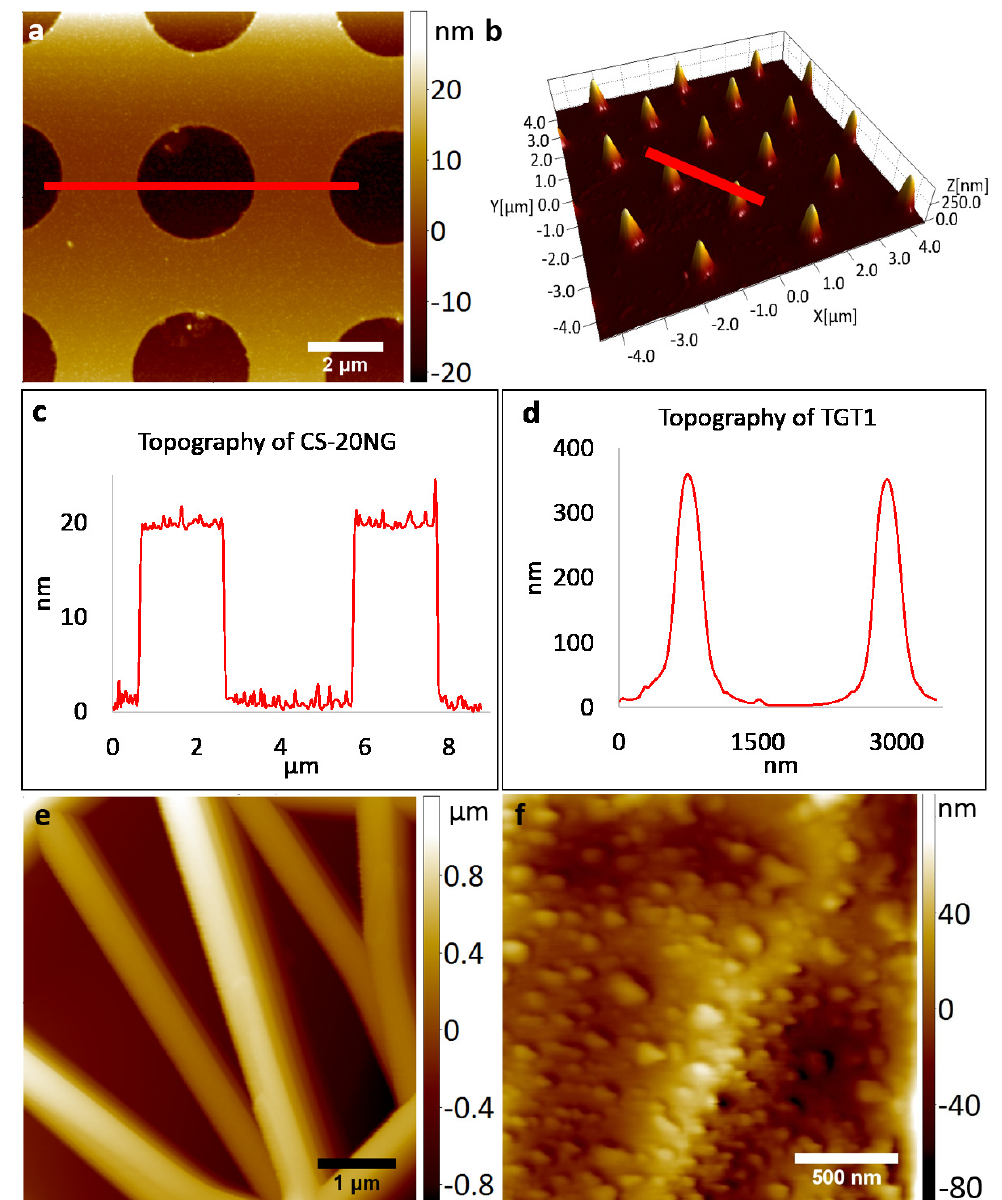
Figure 2. Atomic Force Microscopy (AFM) images recorded with glassy carbon tips. ( a ) Calibration grating CS-20NG; ( b ) calibration grating TGT1, with cross-sections indicated by solid lines in ( c , d ), respectively. AFM images of ( e ) a carbon nanofiber mat and ( f ) electroplated